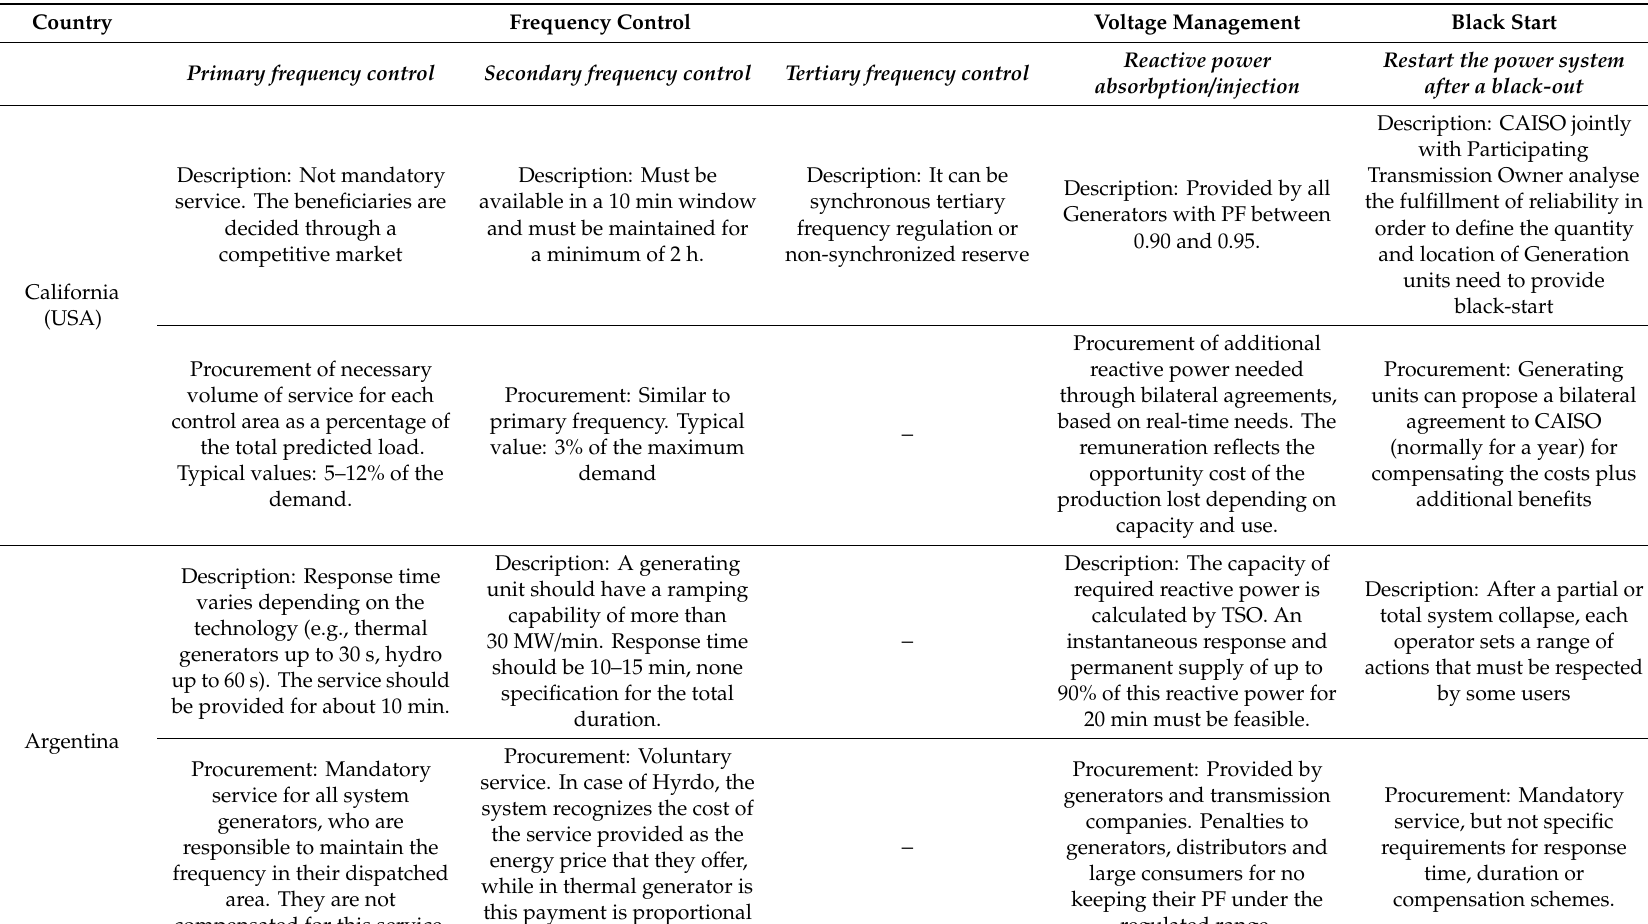
Table A4. Summary of AS and their procurement in several non-EU